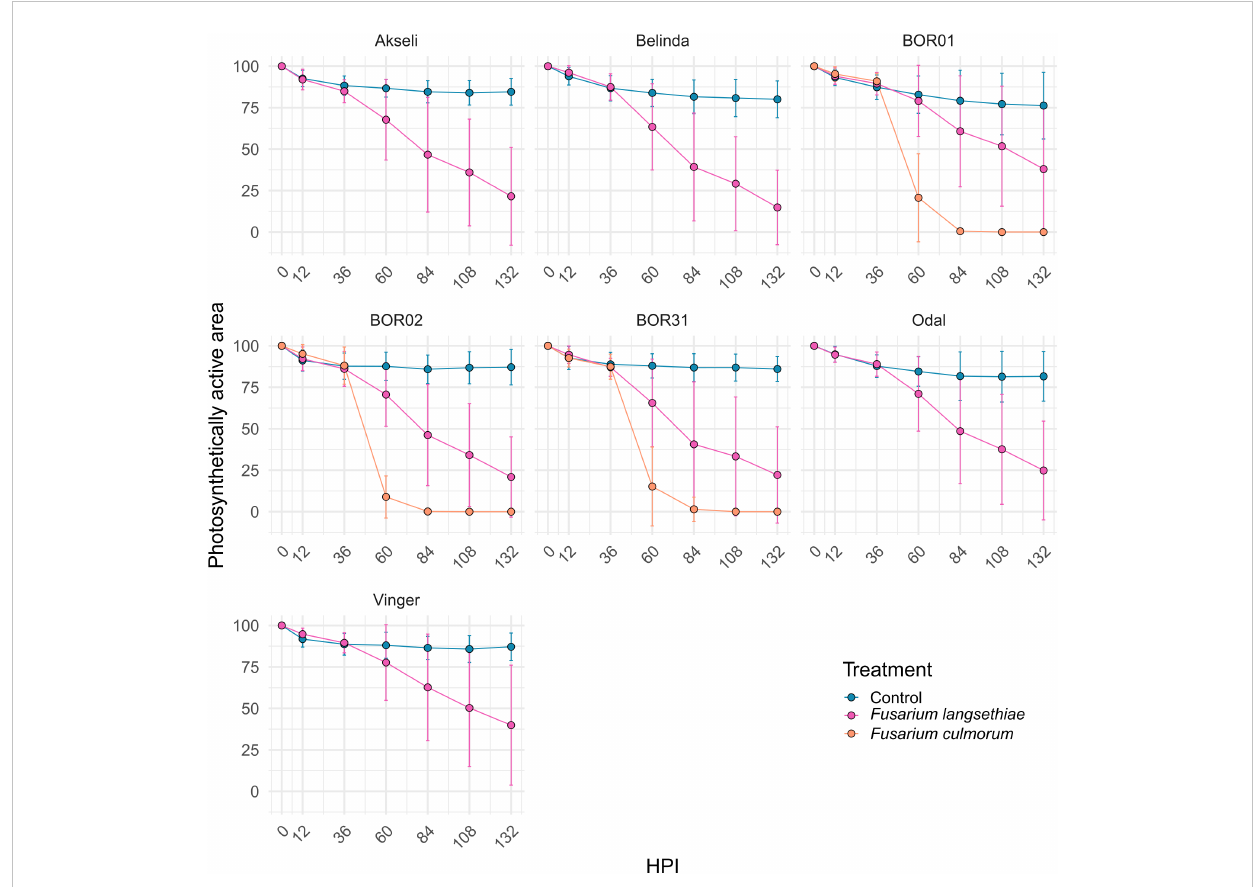
FIGURE 4 Time series of the photosynthetically active area of spikelets. Each measurement represents the percentage of spikelet fl uorescent area relative to its size at 0 hours post inoculation (HPI). All oat genotypes were inoculated with control (mock) and F. langsethiae . BOR01, BOR02, and BOR31 were inoculated in addition with F. culmorum . Blue line, vacuum control; magenta line, inoculated with F. langsethiae ; orange line, inoculated with F. culmorum . Dots represent means per treatment at each HPI measured and error bars represent standard deviation. This analysis includes combined data from two experimental batches. Each data point represents the mean of 21 – 38